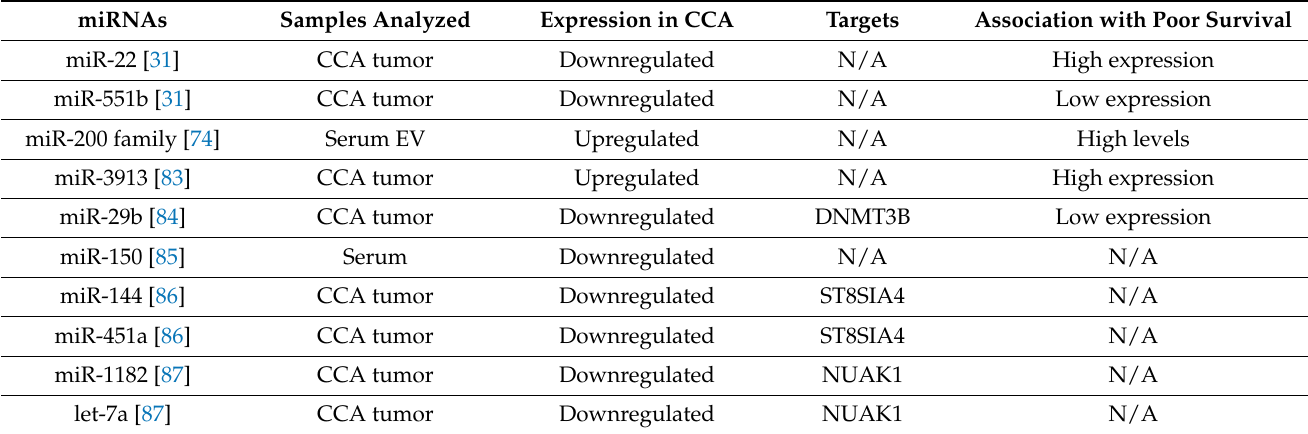
Table 3. Selected miRNAs identified in recent CCA studies.